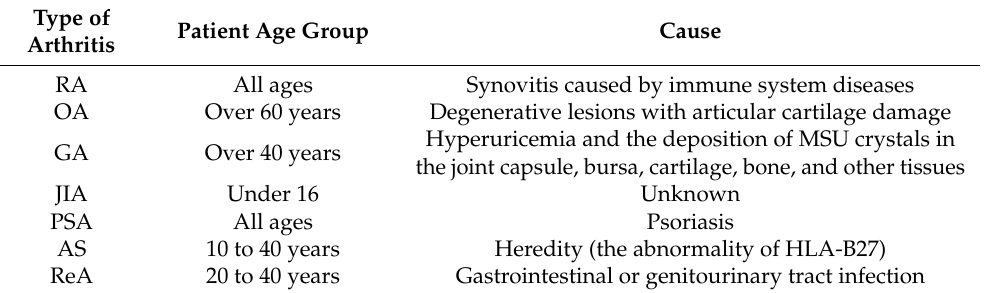
Table 1. Features of some common